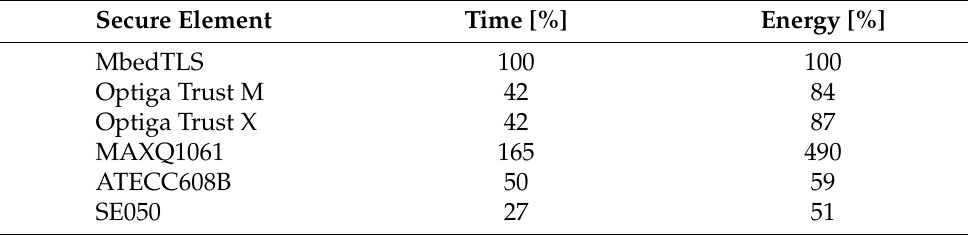
Figure 10. Time and energy measured for calculating an ECDSA signature (secp256r1) relative to the reference implementation. (median of values, rounded to the nearest percent, n = 100). Table 4. Table of values for Figure